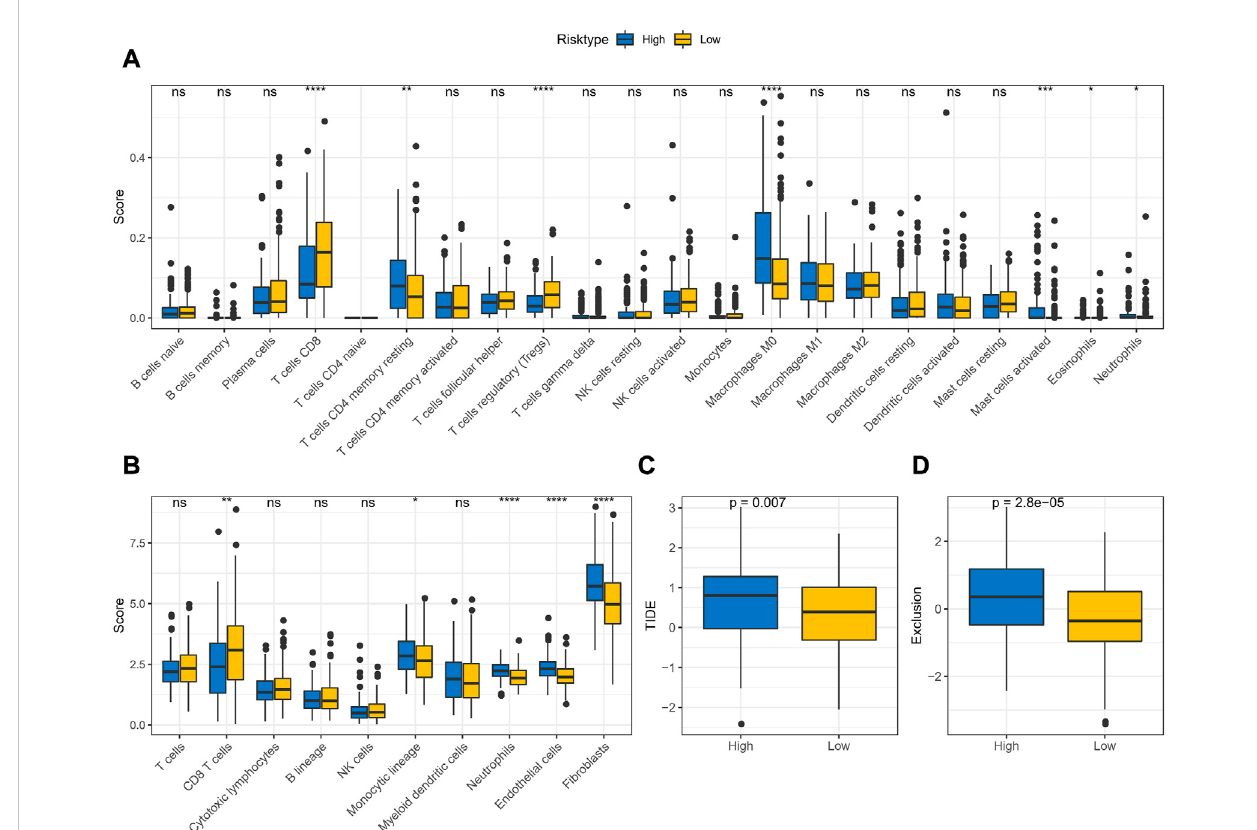
FIGURE 9 TME activity assessment in APR_Score groups (A) Results of immune cell scores estimated by CIBERSORT between APR_Score groups in TCGA- CESC cohort (B) Results of immune cell scores using MCP-count between APR_Score groups in TCGA-CESC cohort (C) Distribution of TIDE score between APR_Score groups in TCGA-CESC cohort (D) Exclusion scores in high-APR_Score group and low-APR_Score group. ns p > 0.05; * p < 0.05; ** p < 0.01; *** p < 0.001; **** p <